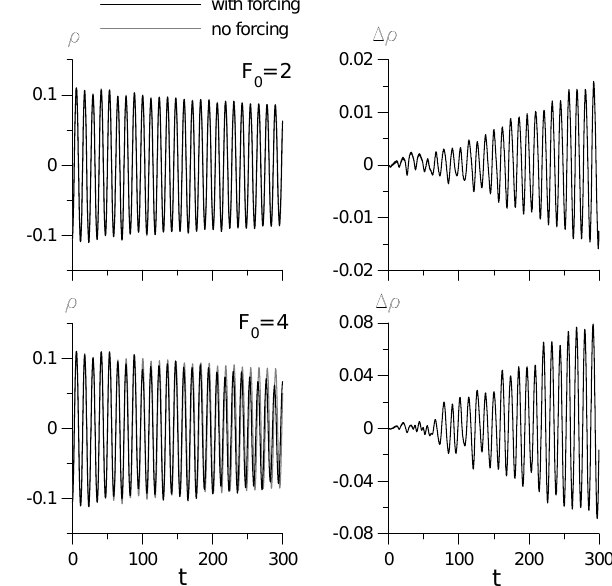
Fig. 8a. Temporal development of the density deviation in center of the pycnocline, at a point with coordinates x = 20, y = 0, z = 8, obtained in DNS for IW wavelength λ = 4, with and without turbulence forcing ρ f and ρ (in black and grey line, left column) and the difference ρ − ρ f (right column) for forcing amplitudes F 0 = 2 (top) and F 0 = 4 (bottom).